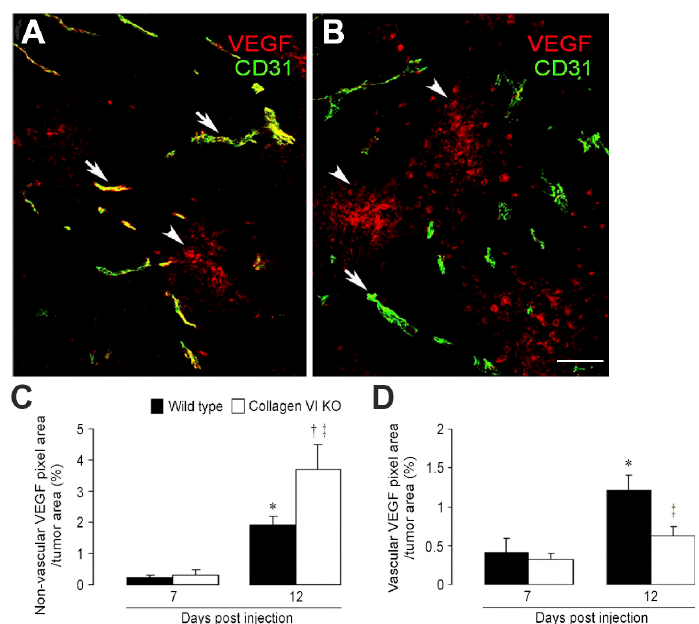
Figure 2. Altered VEGF-A localization following ablation of collagen, V.I. Immunostaining for VEGF-A (red) and CD31 (green) was used to quantify and localize VEGF-A sequestration in tumors from control ( A ) and collagen VI null ( B ) mice. Arrows identify VEGF-A closely associated with tumor blood vessels. Arrowheads identify VEGF-A distributed more diffusely in the tumor parenchyma. Non-vascular VEGF-A in collagen VI null tumors is increased 2-fold compared to control tumors ( C ). In contrast, vascular VEGF-A in collagen VI null tumors is reduced 2-fold compared to control tumors ( D ). Scale bar: 120 µ m. * p < 0.05. † p < 0.05 versus 12-day wild type. ‡ p < 0.002 versus 7-day collagen VI null. Data taken from (You et al., [24]).